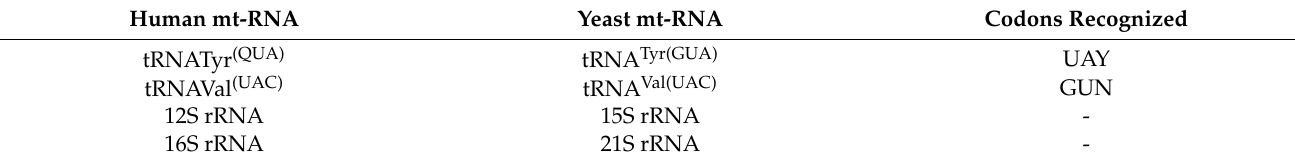
Abbreviations are as in Table 1. Other abbreviations: cmcm 5 s 2 U: 5- 5-carboxymethylaminomethyl -2-thiouridine; Y: pyrimidine; R: purine; N: every nucleotide; fMet: formyl-methionine. a Humans possess a single tRNA